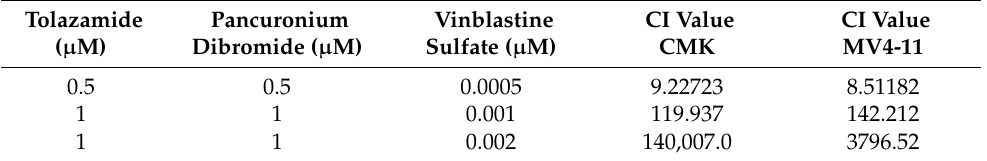
Table 3. Combination index (CI) values calculated using the Chou and Talalay method for the combination of tolazamide (T), pancuronium dibromide (PD) and vinblastine sulfate (VS). Tolazamide ( µ M)